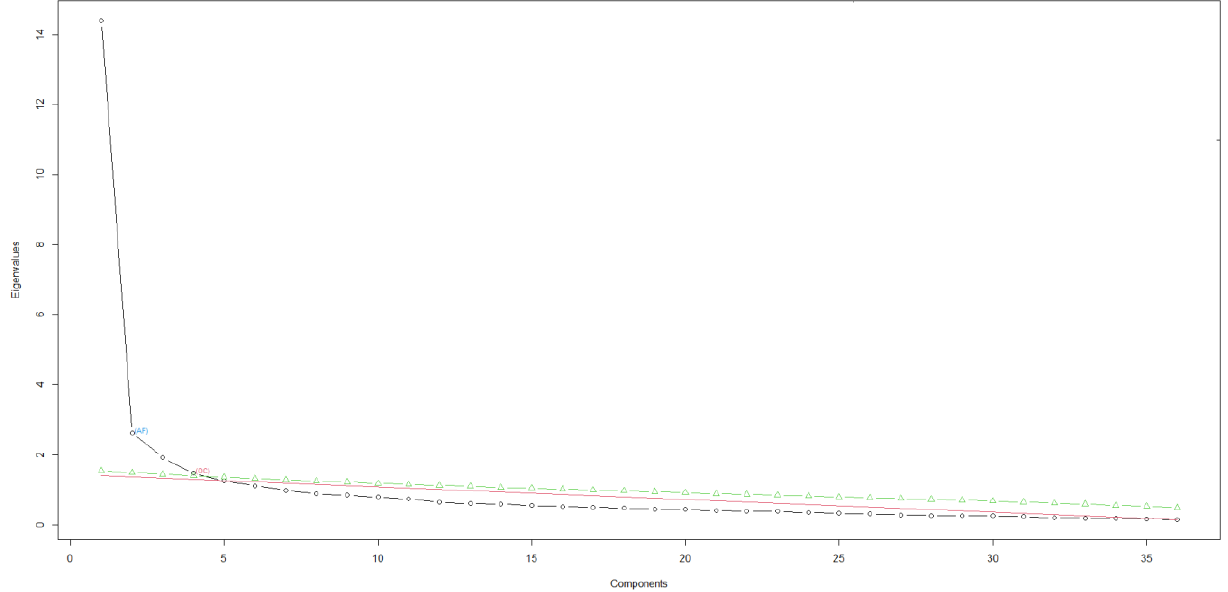
Figure 1. Description of the results of the “scree-plot” of the eigenvalues shows an inflection in the third